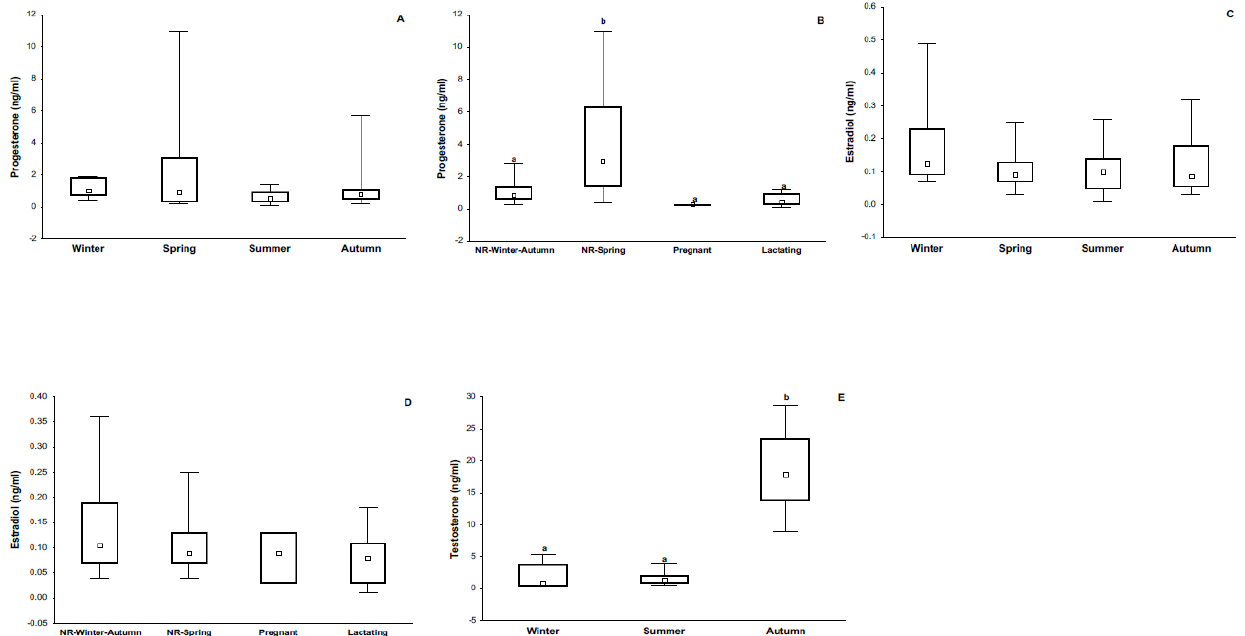
Figure 1. Concentration of steroid sex hormones in the plasma of female and male fish-eating myotis ( Myotis vivesi ) in Partida Norte Island, Mexico. The values were compared among seasons for both sexes ( A , C , E ) and among the reproductive categories for females ( B , D ). The values are the median (square), interquartile range (box), and 5th and 95th percentiles (whiskers). Only significant differ- ences among the log 10 -transformed hormone concentration values are pointed out using different letters after factorial analysis of variance. NR = females with no external signs of reproductive activ- ity.